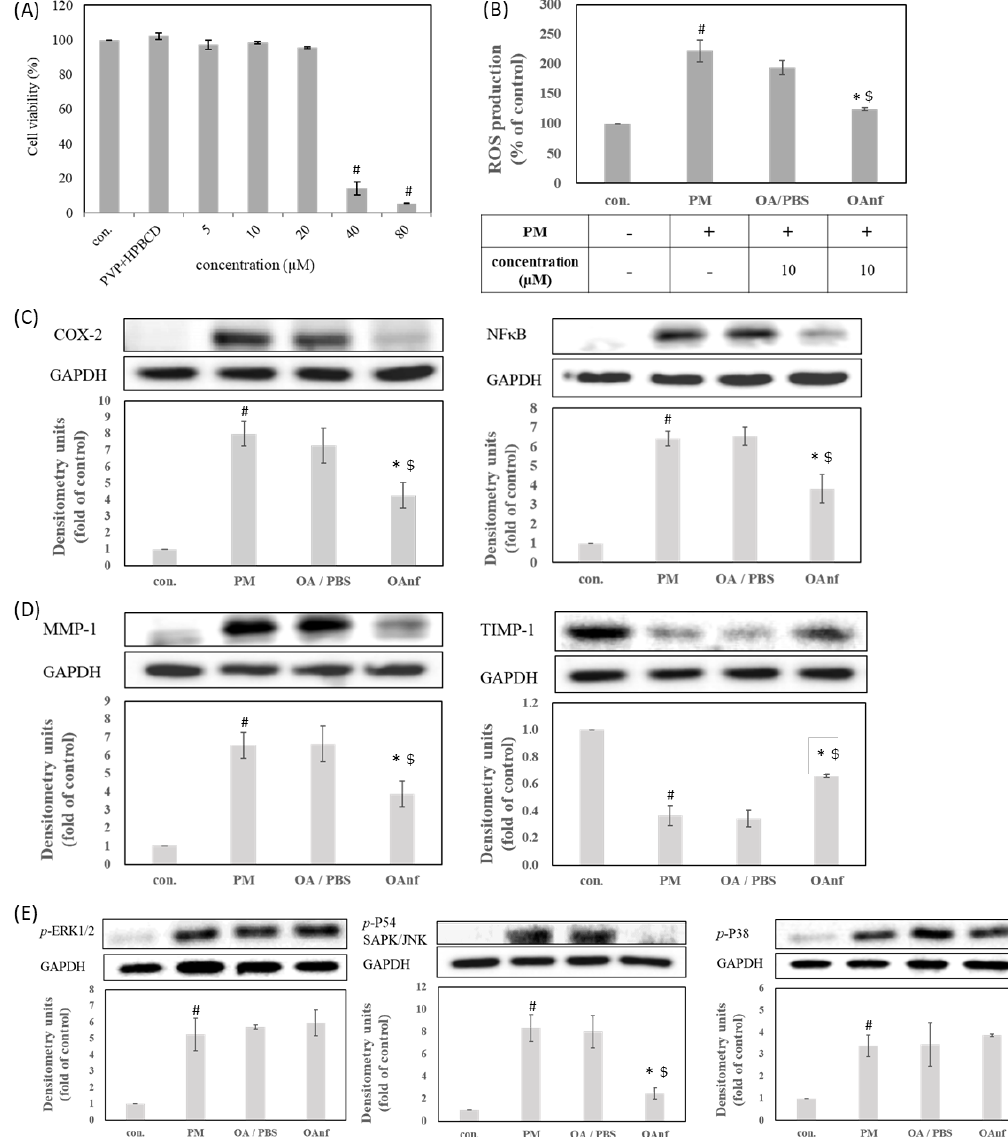
Figure 8. Oleanolic acid nanofiber inhibits the protein expression of inflammation and aging in PM − induced keratinocytes damage through the ROS/MAPKs pathway. ( A ) Cell viability, ( B ) ROS production, ( C ) COX-2 and NF- κ b, ( D ) MMPs and TIMP-1 protein expression, ( E ) phosphorylation of MAPKs. A p -value < 0.05 was interpreted as statistically significant, # refers to PM treatment versus negative control, * refers to PM treatment versus OAnf, and $ refers to OA/PBS versus OAnf. Table 4. The percentage change of protein expression from OA and OAnf in PM-induced HaCaT cell damage.